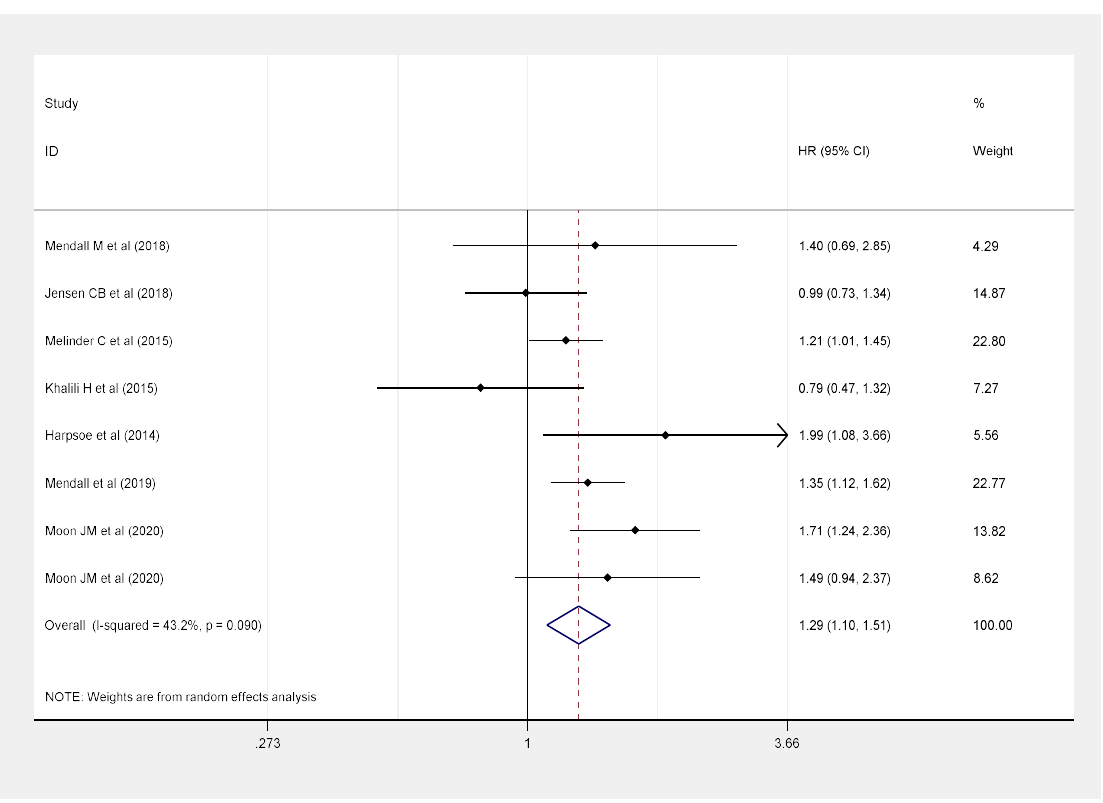
Figure 3. Association between underweight (BMI <18.5 kg/m 2 ) and risk of Crohn’s disease.